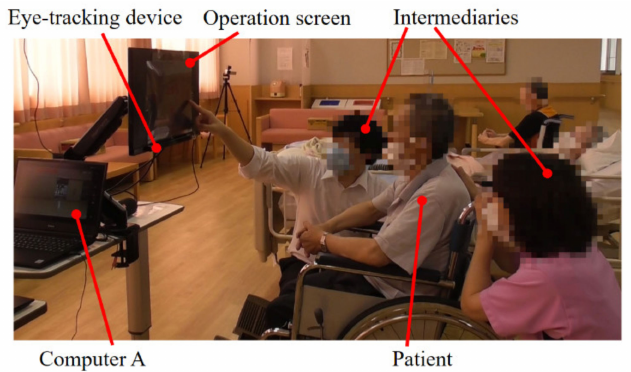
Figure 4. Patient (in the hospital